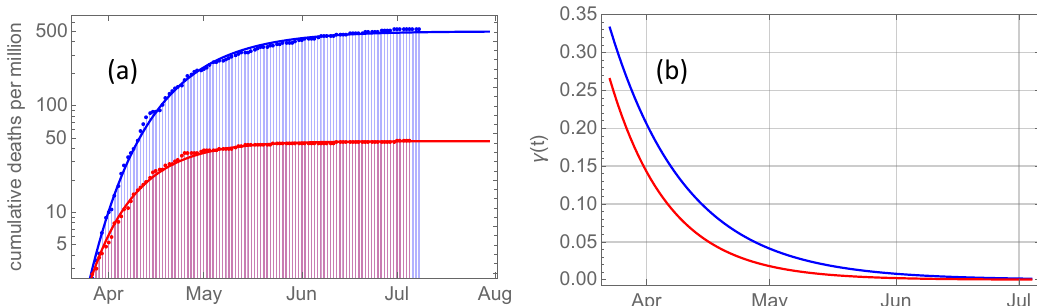
Figure 2. ( a ): Red bullets represent cumulative COVID-19 related deaths per million inhabitants in Norway from March 23 and onwards, and the full curve is the Gompertz curve J ( t ) fitted to these data. The blue bullets and curve are the corresponding for Sweden (shifted 3 days forwards). Note that the plot is logarithmic, and that cumulated death toll per million in Sweden in early July is 12 times that in Norway. ( b ): The relative growth rate γ ( t ) = d t ( ln J ) as given by Equation (6) for Norway (red) and Sweden (blue). These growth rates are the slopes of the curves in ( a ).